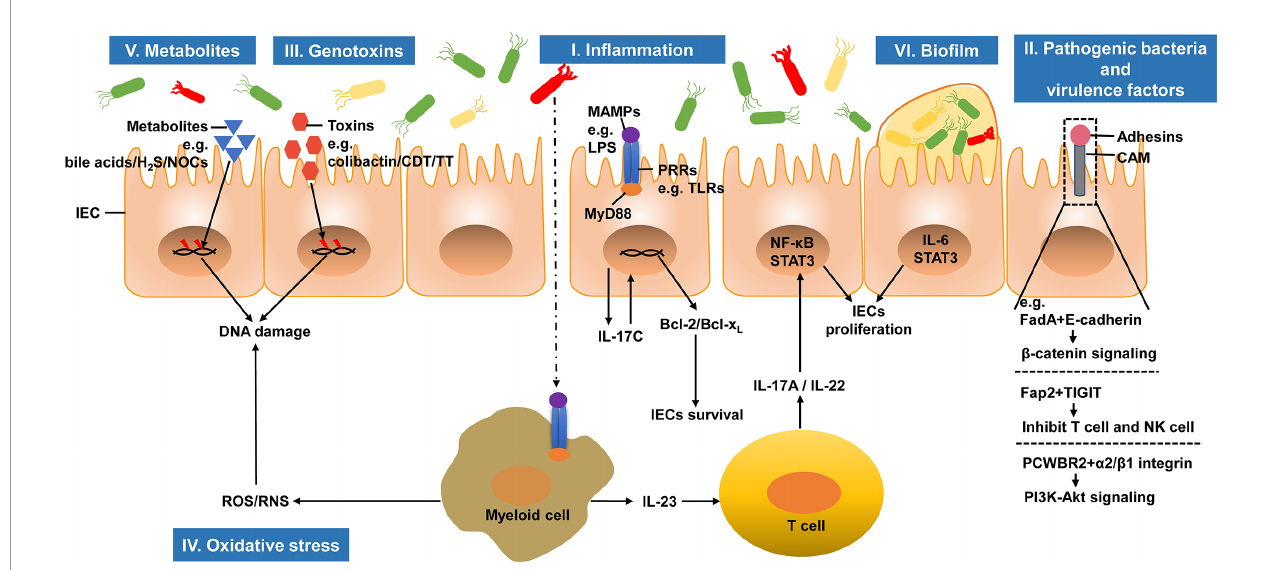
FIGURE 1 | Microbiota-associated mechanisms in colorectal carcinogenesis. The intestinal microbiota can regulate the initiation and progression of CRC. I. The in fi ltration of commensal bacteria or their products activates tumor-associated myeloid cells and induces tumor promoting in fl ammation. II. Pathogenic bacteria and their virulence factors adhere to IECs and promote tumorigenesis. III. Genotoxins produced by bacteria induce DNA damages in IECs and initiate CRC development. IV. Under the stimulation of chronic in fl ammation, in fl ammatory cells can produce ROS and RNS, which in turn induce DNA damage. V. Several bacterial metabolites, including secondary bile acids, H 2 S and NOCs, can cause DNA damage, which promote CRC carcinogenesis. VI. Bio fi lm, microbial communities, promotes carcinogenesis through IL-6 and its downstream effector STAT3 activation. IEC, intestinal epithelial cell; H 2 S, hydrogen sul fi de; NOCs, N-nitroso compounds; CDT, cytolethal distending toxin; TT, typhoid toxin; MAMP, microbe-associated molecular pattern; LPS, lipopolysaccharide; PRR, pattern recognition receptor; TLR, Toll- like receptor; MyD88, myeloid differentiation factor 88; NF- k B, nuclear factor- k B; STAT3, signal transducer and activator of transcription 3; CAM, cell adhesin molecule; FadA, Fusobacterium adhesin A; TIGIT, T-cell immunoglobulin and ITIM domain; PCWBR2, putative cell wall binding repeat2; ROS, reactive oxygen species; RNS, reactive nitrogen